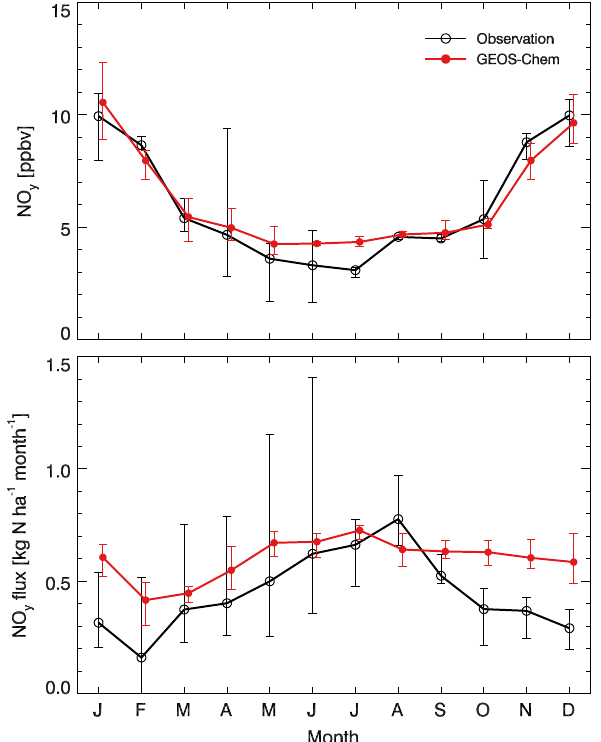
Fig. 8. Monthly NO y concentrations (top) and dry deposition fluxes (bottom) at Harvard Forest, Massachusetts (42.53 ◦ N, 72.18 ◦ W). Concentration and eddy covariance flux measurements for 1999- 2002 (black) are compared to model results averaged for 2006-2008 (red). The vertical bars indicate the range of the monthly mean val- ues for the four years of measurements and three years of model